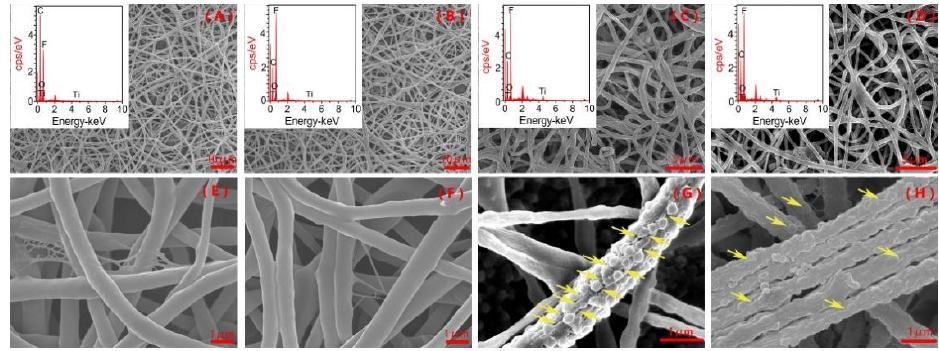
Figure 1. SEM images and EDS spectra of PVDF–PVP ( A , E ), PVDF–PVP–TiO 2 2% ( B , F ), PVDF–PVP– TiO 2 5% ( C , G ), and PVDF–PVP–TiO 2 10% ( D , H ) fiber mats. Arrows point to surface pores.